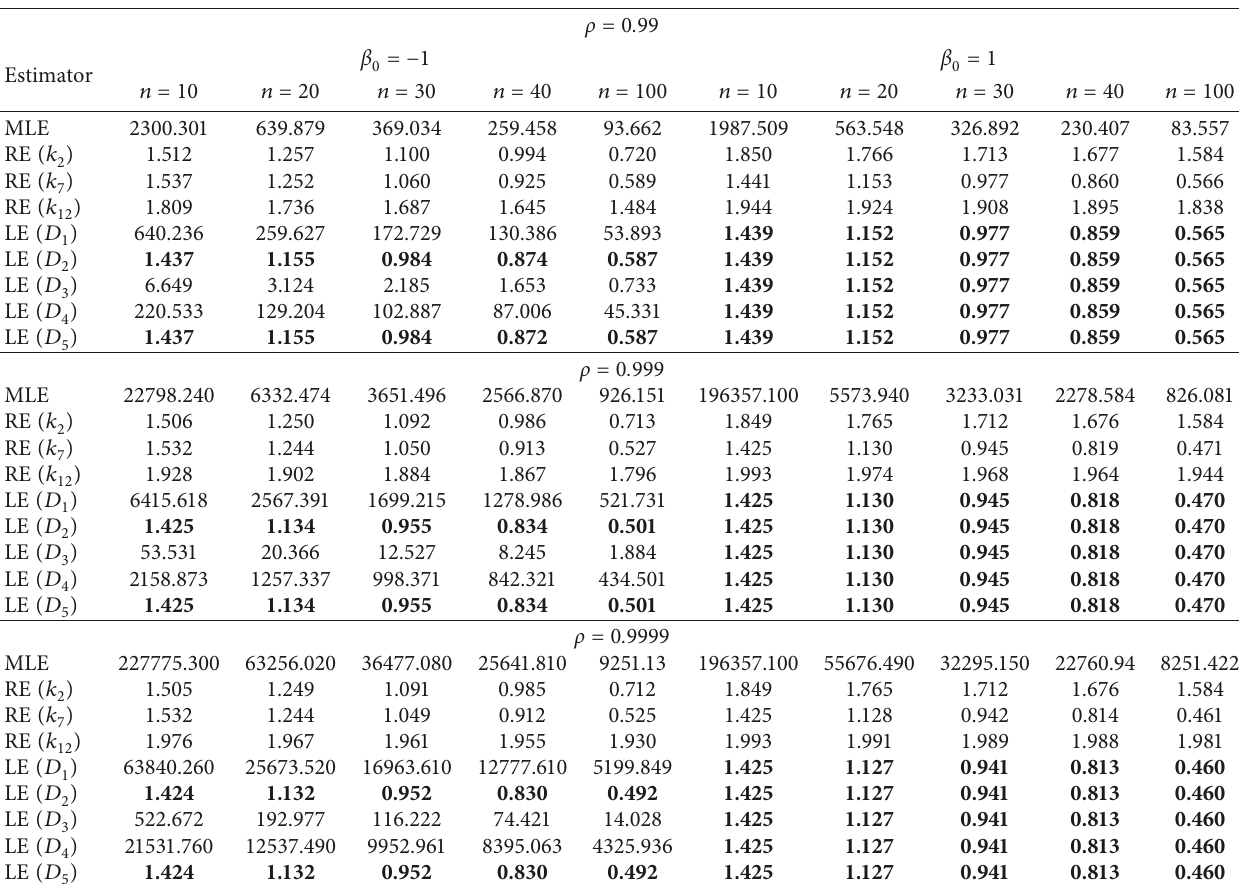
Table 7: Estimated SMSE values for different n, ρ ,k, d, and β